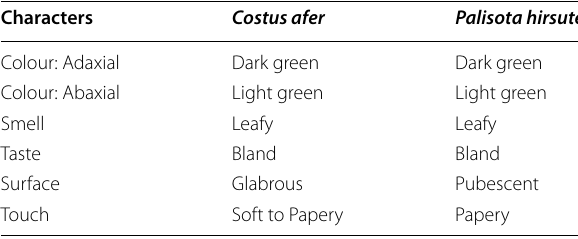
Table 2 Organoleptic properties of Costus afer and